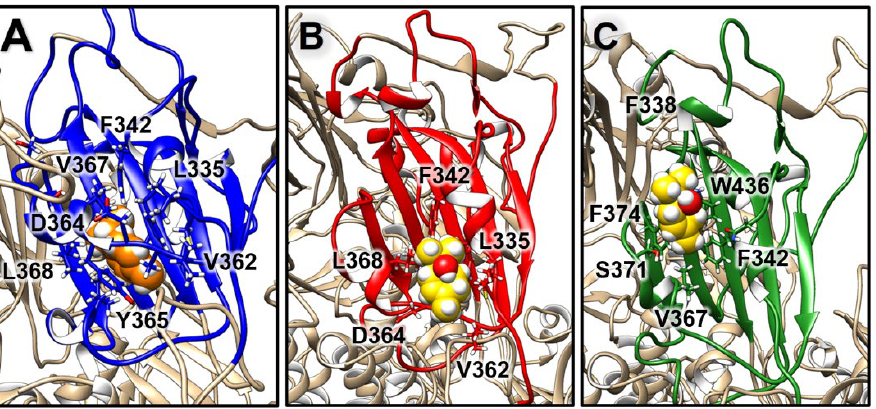
Figure 5. Comparison of the binding poses observed for ( A ) γ -terpinene, colored in orange, and ( B ), ( C ) terpinen-4-ol, colored in yellow, on the three S RBDs, highlighted in blue, red, and green.